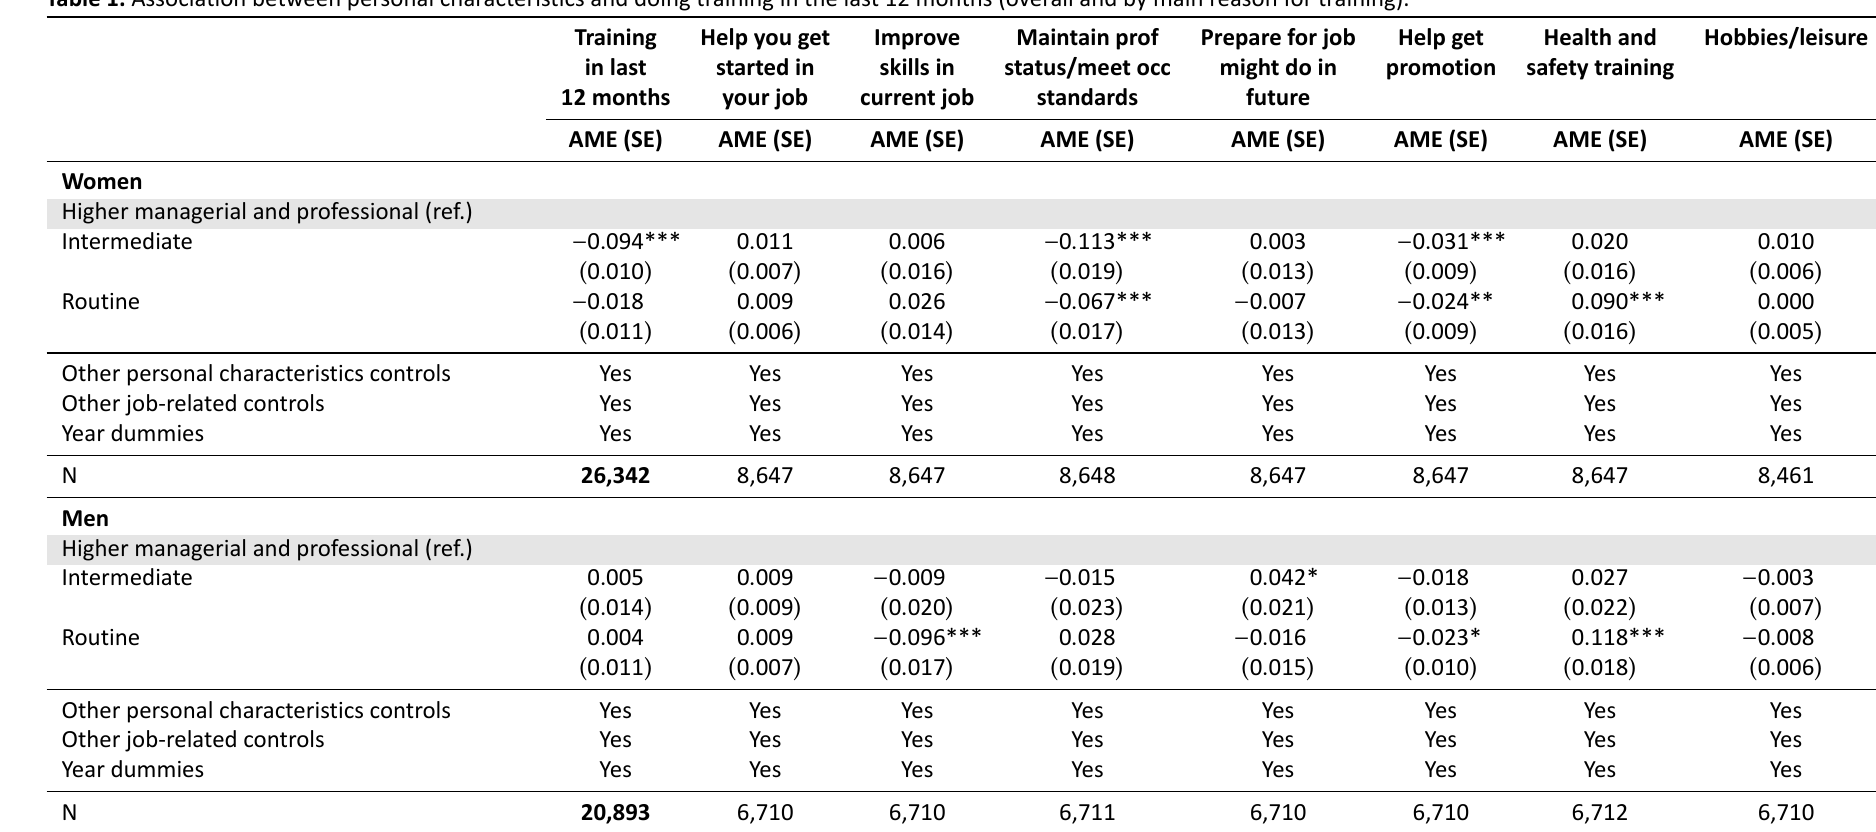
Table 1. Association between personal characteristics and doing training in the last 12 months (overall and by main reason for training). Training Help you get Improve Maintain prof Prepare for job Help get Health and Hobbies/leisure